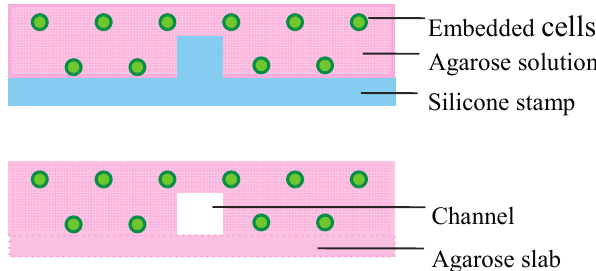
Figure 3. Soft lithographic approach for fabrication of microfluidic constructs. Agarose solution embedded with hepatic cells was gelled on a SU-8 patterned silicon wafer and microfluidic channels were formed by heating and sealing of the surface of two molded agarose